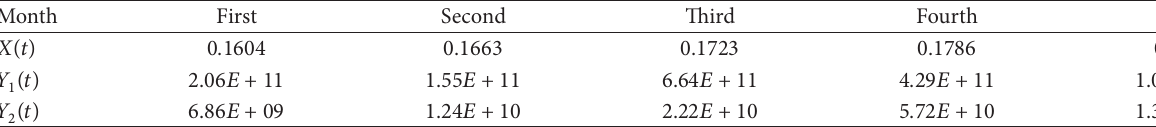
Table 10: Input and outputs center of gravity for DMU 9 .